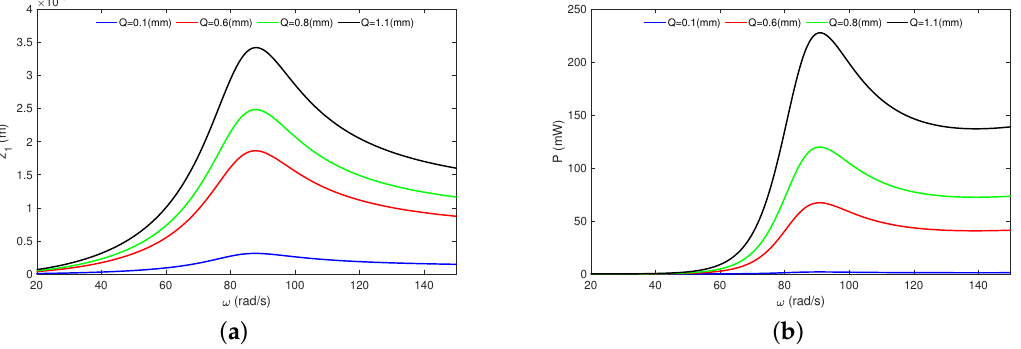
Figure 7. Analytical HBM results. The moving magnet’s resonance curves ( a ) and the recovered power ( b ) under the external periodic excitation. The results have been calculated for the resistance R = 2.0 k Ω . The results have obtained from Equations (27) and (28). All resonance responses are